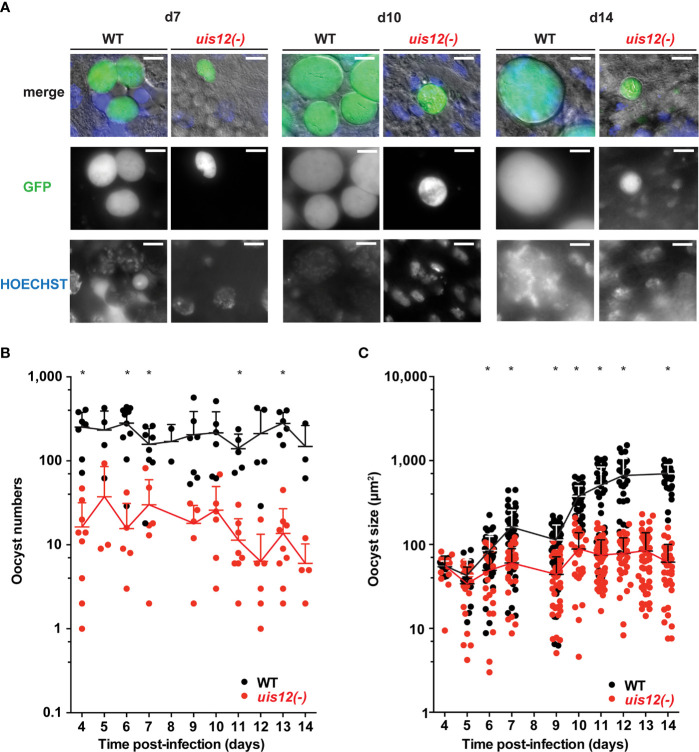
Disruption of UIS12 leads to a reduced oocyst size and a defect in sporozoite formation. (A) Shown are representative live micrographs of uis12(-) and wild-type oocysts 7, 10 and 14 days after an infectious blood meal. GFP (green) is constitutively expressed under the HSP70 promoter (P. berghei ANKA Bergreen) (Kooij et al., 2012). Uis12(-) clone 2 was used for this experiment. Nuclei were stained with Hoechst (blue). Note the reduced density and size of uis12(-) oocysts, and absence of sporozoites in uis12(-) oocysts. Magnification, 630-fold; scale bars, 10 µm. (B, C) Time course of oocyst numbers per infected mosquito midgut (B) and oocyst size (µm2) (C) at different time points after midgut infection (uis12(-) clone 2, red; WT, black). *p < 0.05 (multiple t-tests).